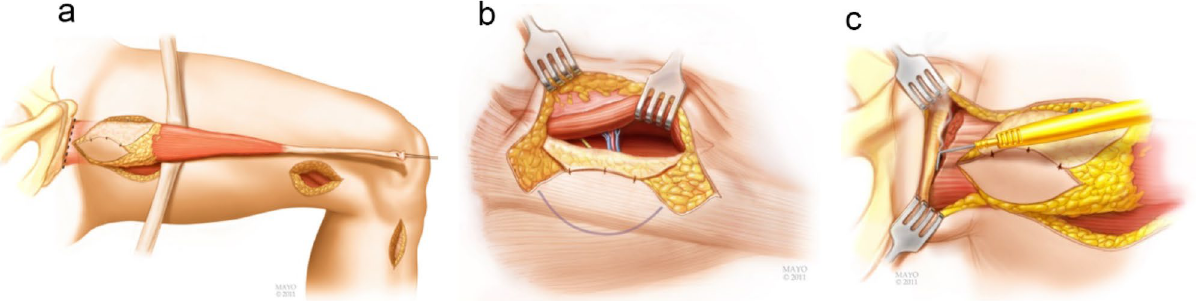
Figure 12. Gracilis Harvest. ( a ) Release of gracilis distally and passed through proximal thigh incision. ( b ) Gracilis neurovascular bundle. ( c ) release of gracilis proximally. (Printed with permission of the